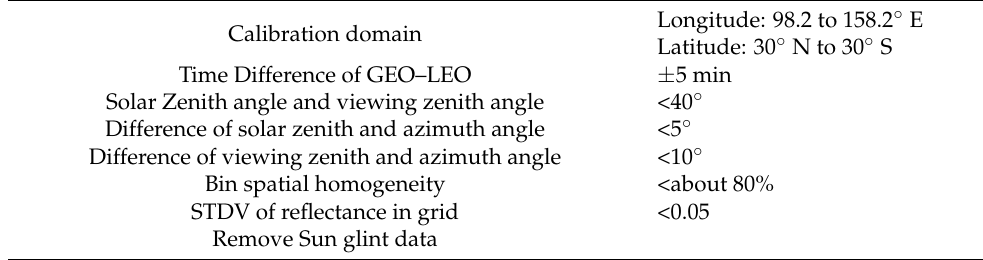
Table 3. Thresholds for inter-comparison among AMI, MODIS, and VIIRS using ray-matching method.